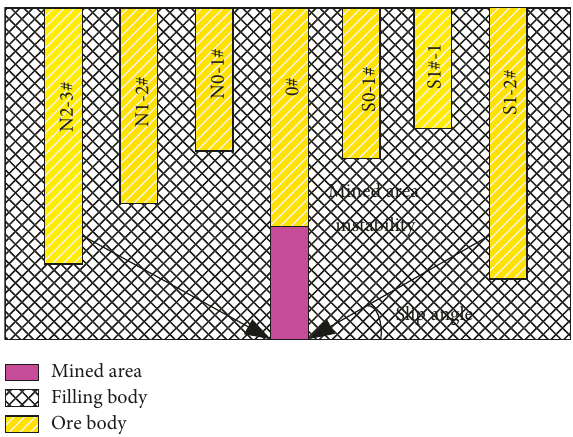
Figure 1: Status of instability collapsed